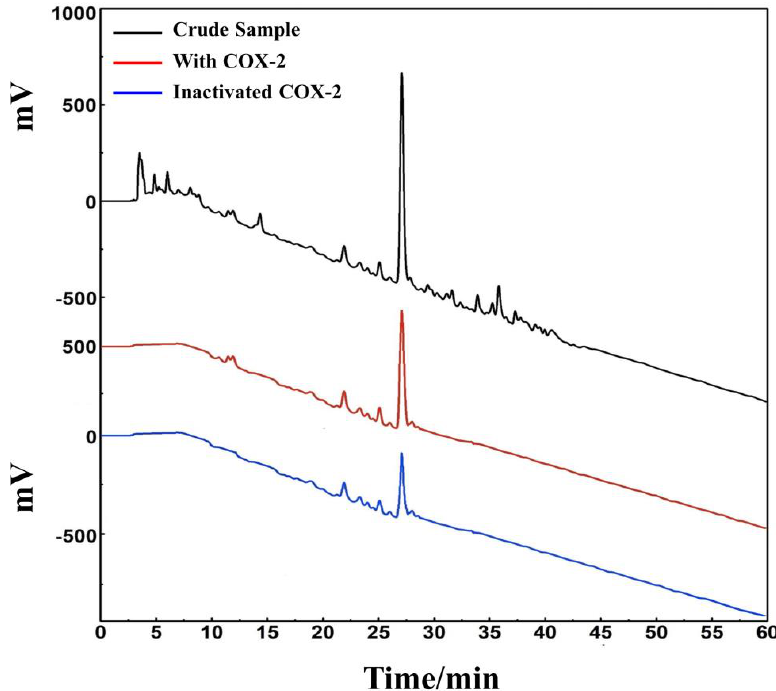
Figure 7. An affinity ultrafiltration-HPLC chromatogram for potential COX-2 ligands present in the ethyl acetate extraction of D. heterophyllum . The black, red, and blue lines, respectively, correspond to the HPLC chromatograms of the ethyl acetate extraction of D. heterophyllum without COX-2, with activated COX-2, and with inactivated COX-2. Conditions: mobile phase A: 0.1% v / v formic acid in water, B: MeOH; gradient elution: 0–60 min, 0–100% B; flow rate: 1.0 mL/min; monitoring wavelength: 210 nm; injection volume: 2 µ L; column temperature: 30 ◦